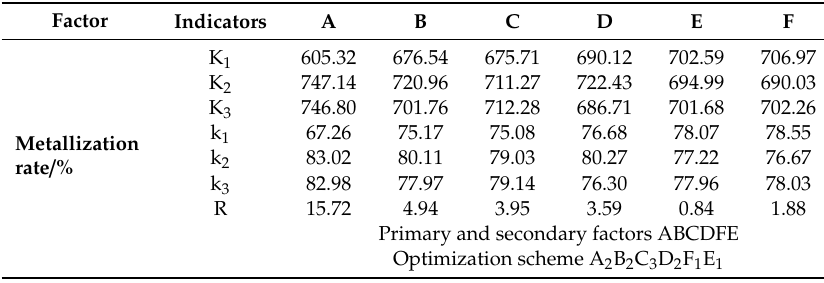
Table 7. Analysis of metallization rate results.